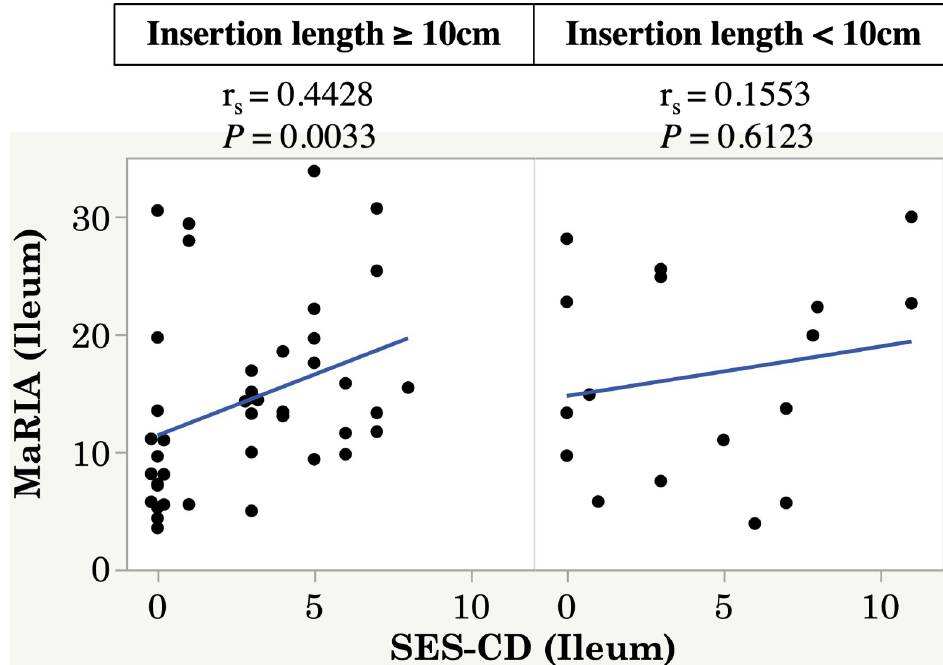
ileum, n = 17) or (with observing less than 10 cm of distal ileum, n =